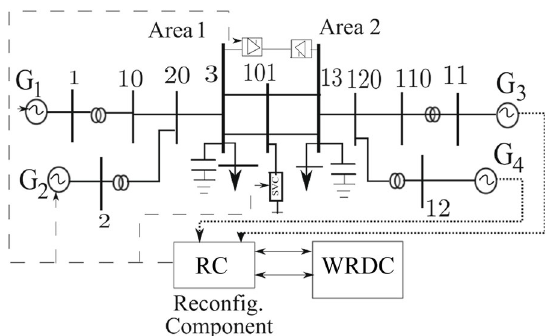
Fig. 3 Two-Area Power System with WAC: Dotted lines show remote feedback connections & dashed lines show wide area control input